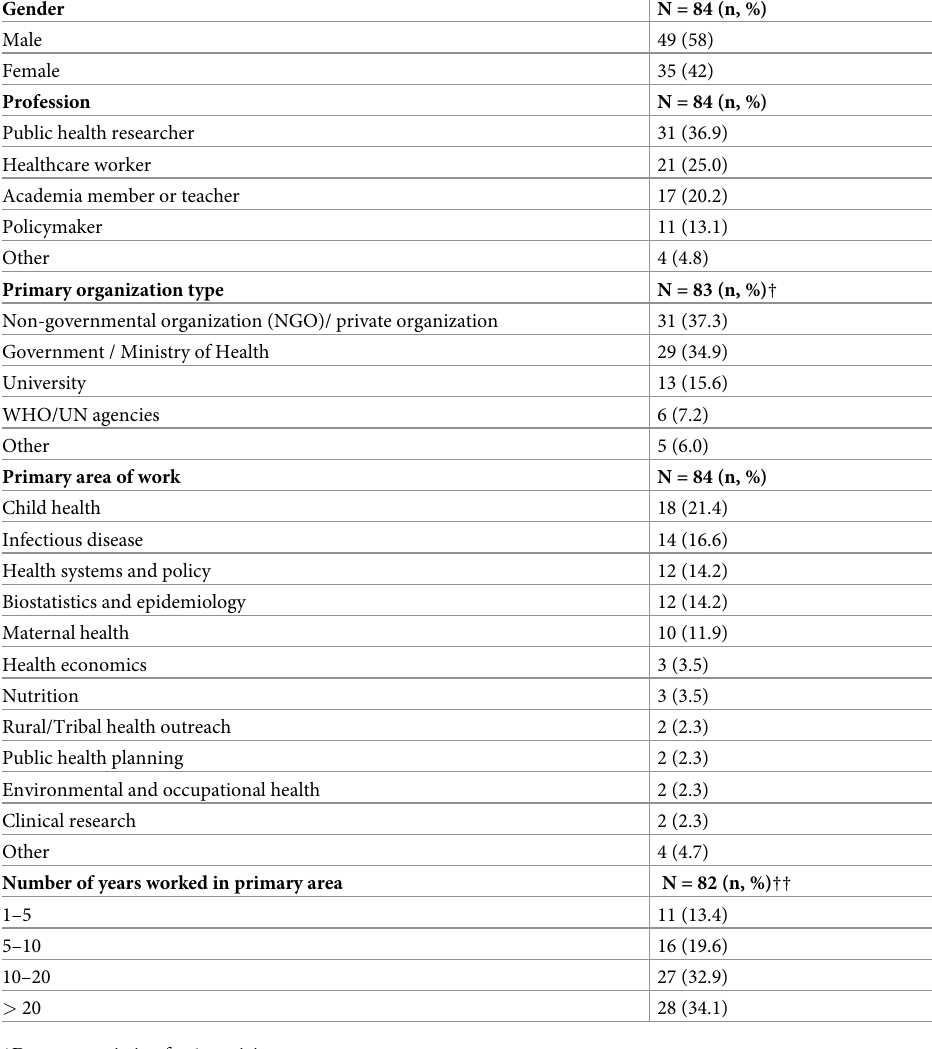
Table 1. Characteristics of survey